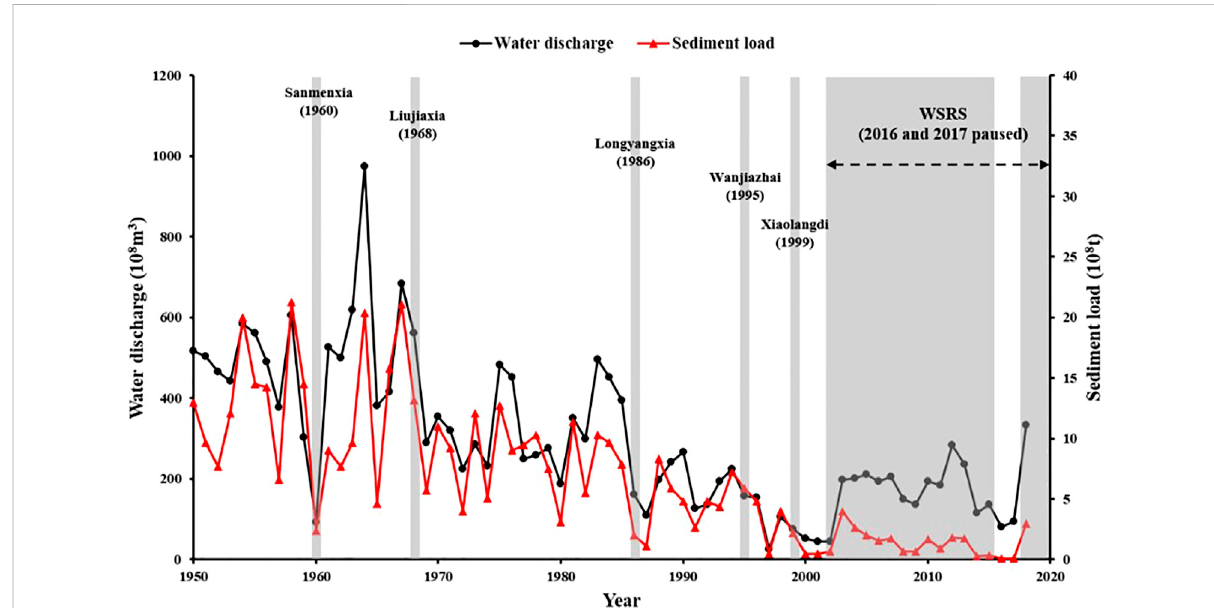
FIGURE 2 Annual levels of water and sediment discharged at the LJ station from 1950 to 2018. Grey shadow bars represent the year of each reservoir construction and the years of implementation of WSRS in the YRB since